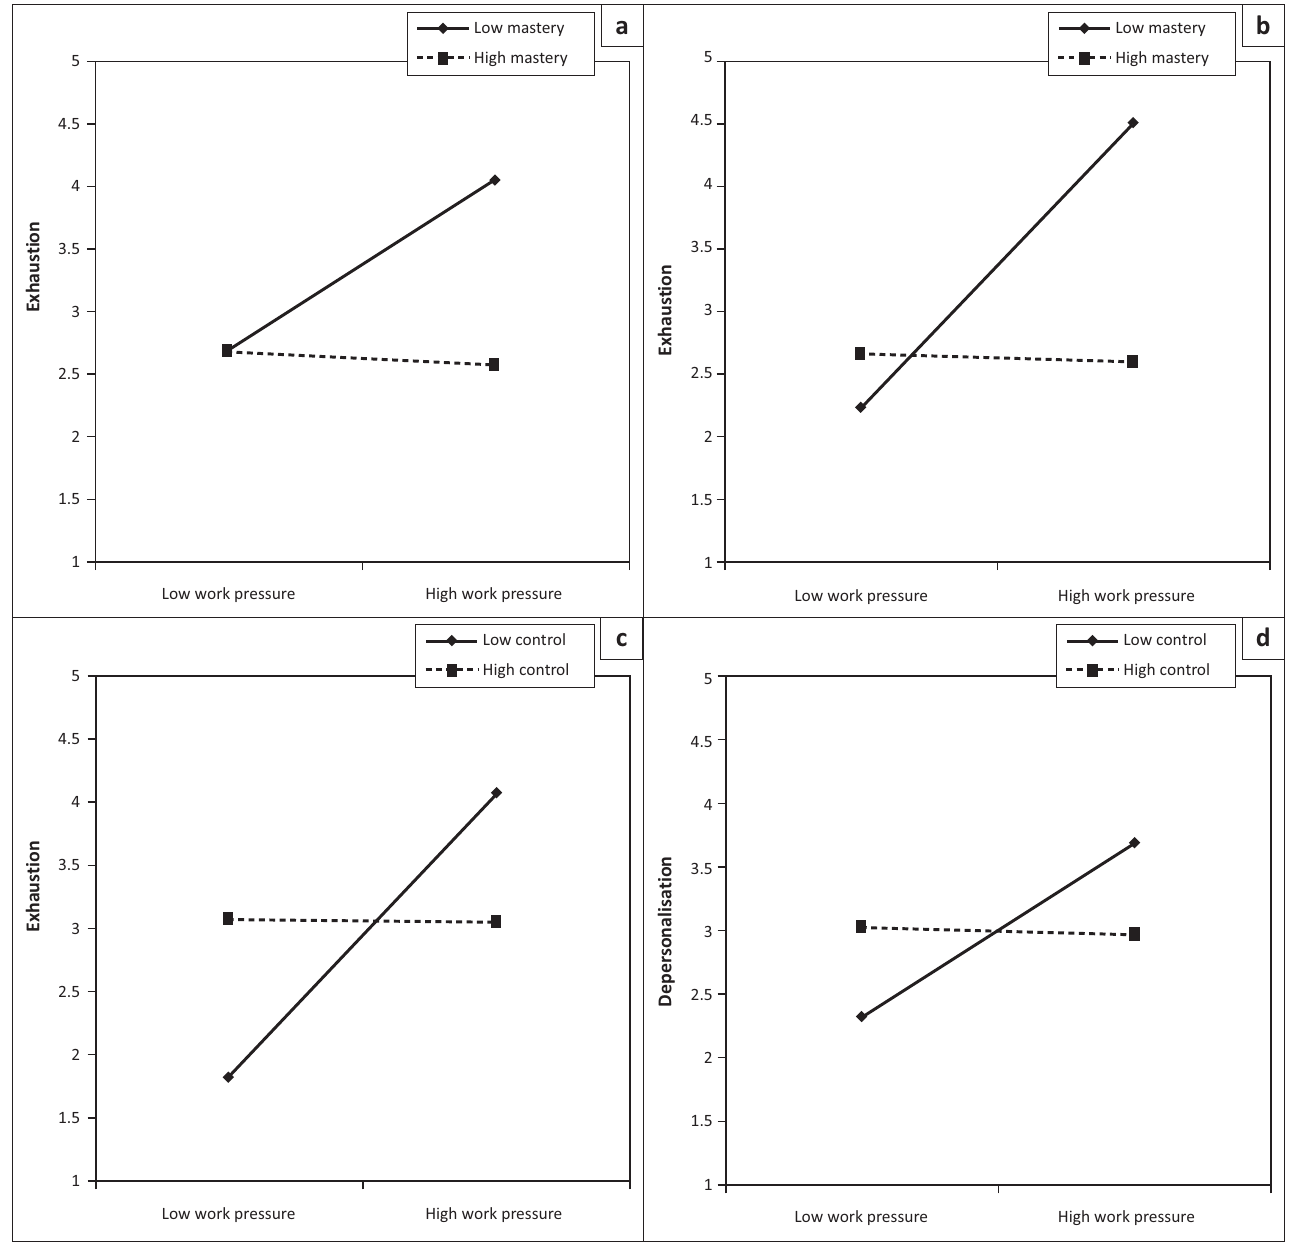
FIGURE 1: The four significant moderating effects plotted graphically